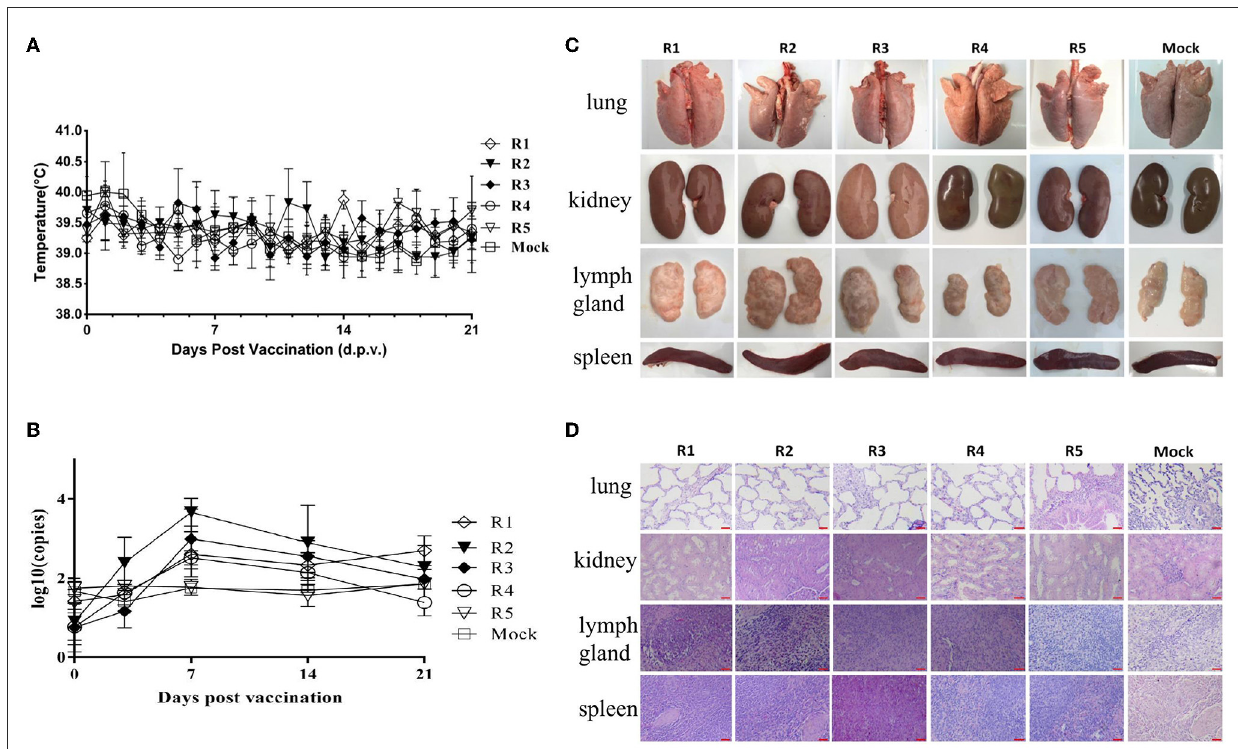
FIGURE1 Safety identification of rPRRSV-E2 vaccination group and pig–pig in vivo serial passage sera inoculation group. The values of mock groups of each generation were indicated together. (A) Daily rectal temperature record of the rPRRSV-E2 inoculation group and the in vivo passage groups. (B) Viral RNA replication in serum samples detection for the rPRRSV-E2 inoculation group and the pig–pig in vivo generation sera inoculation group. Five piglets in each generation were inoculated with virus/serum samples, named R1–R5 groups, respectively, and each generation of pigs was one-to-one corresponded during the experiment. (C) Gross pathological changes of organs and tissues (spleen, lung, kidney, and lymph node) of rPRRSV-E2 inoculation group and in vivo passage sera inoculation group after necropsy. (D) Histopathological observation of organs and tissues (spleen, lung, kidney, and lymph node) of rPRRSV-E2 inoculation group and in vivo serial passage sera inoculation group after necropsy. Scale bar = 200 µ